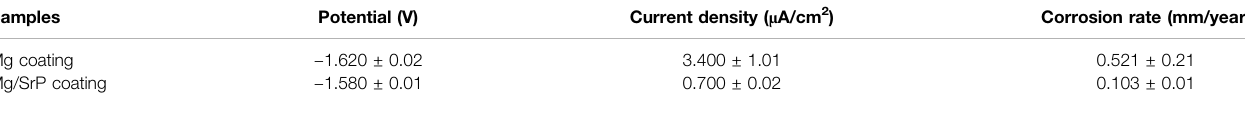
TABLE 2 | Tafel fi tting results based on potentiodynamic polarizations tested in D-Hank ’ s solution. Samples